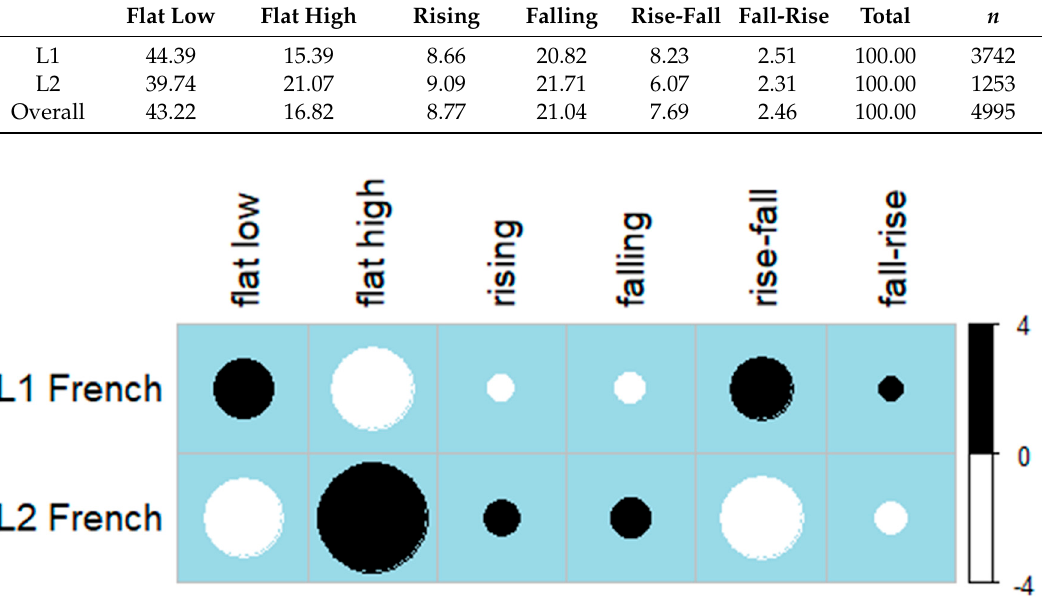
represents correlation strength. Table 7. Profile distribution by speaker group, expressed in % of each group.